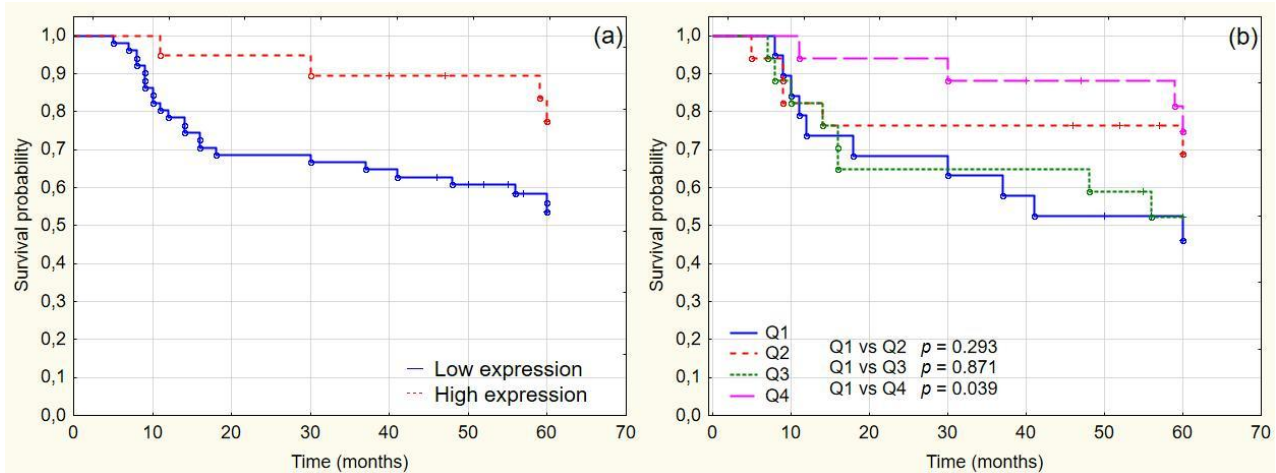
Figure 3. OS analysis of TMA cohort ( a ) overall survival in low CDK9 and high CDK9 groups (5-year OS 77,54% vs. 53.6%, respectively; p = 0.04); ( b ) overall survival by CDK9 expression quartiles.